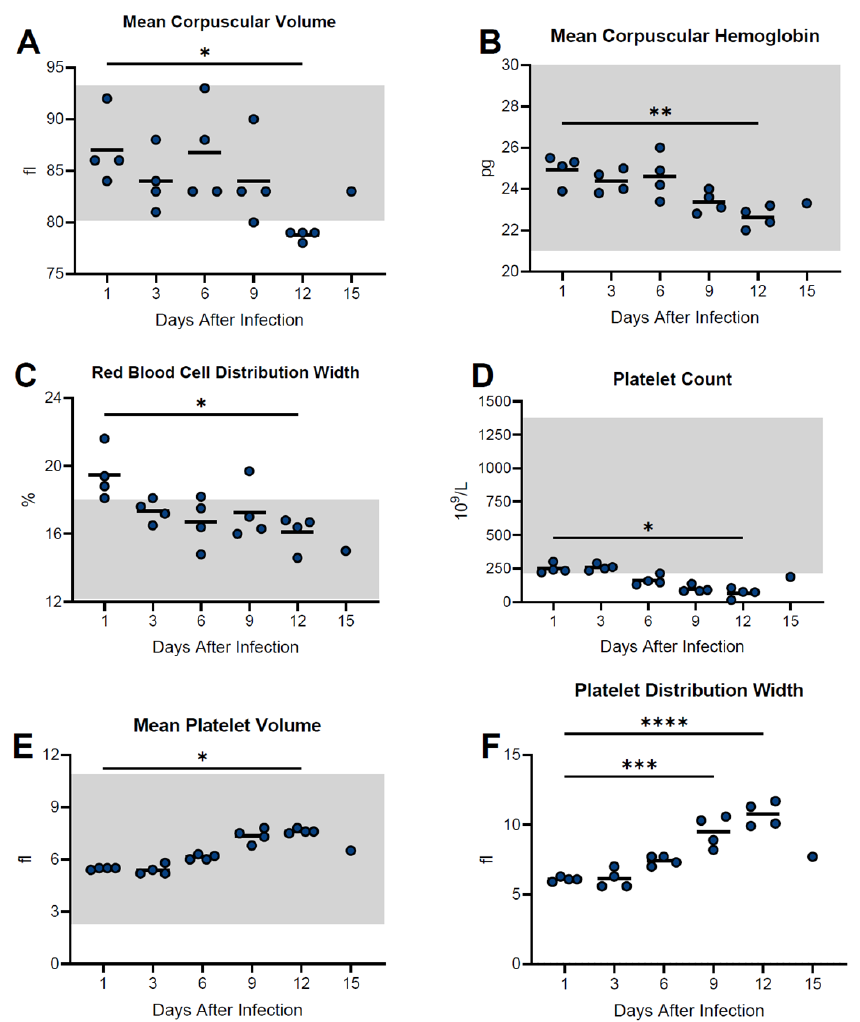
Figure 4. Temporal analysis of hematological values from guinea pigs infected with NML-61/GPA. Twenty-four guinea pigs were inoculated with 100LD 50 of NML-61/GPA. Groups of four animals were euthanized at indicated days post-inoculation and analyzed for hematological abnormalities. Shown are data for mean corpuscular volume ( A ), mean corpuscular hemoglobin ( B ), red blood cell distribution width ( C ), platelet count ( D ), mean platelet volume ( E ), and platelet distribution width ( F ). Dots represent individual animal values; bar represents group averages. Where available, nor- mal ranges are indicated by gray shading (www.criver.com, accessed 8 March 2023). Significant differences where p < 0.05, <0.01, <0.001, and <0.0001 are indicated by *, **, ***, and **** respectively. Notable changes in serum biochemistries included significant decreases in alkaline phosphatase (ALP) at day 12 post-infection, as well as phosphatase (PHOS) at both day 9 and 12 time-points. A transient increase in blood urea nitrogen (BUN) was observed at day 3 post-infection and increased levels of globulin (GLOB) at days 9 and 12 post-infec- tion were also observed (Figure 5). The remaining parameters, including alanine ami- notransferase (ALT), amylase (AMY), total bilirubin (TBIL), calcium (CA), creatinine (CRE), glucose (GLU), sodium (NA), potassium (K), and total protein (TP), remained rel- atively unchanged during infection (Figure 5, Supplemental Figure S2).